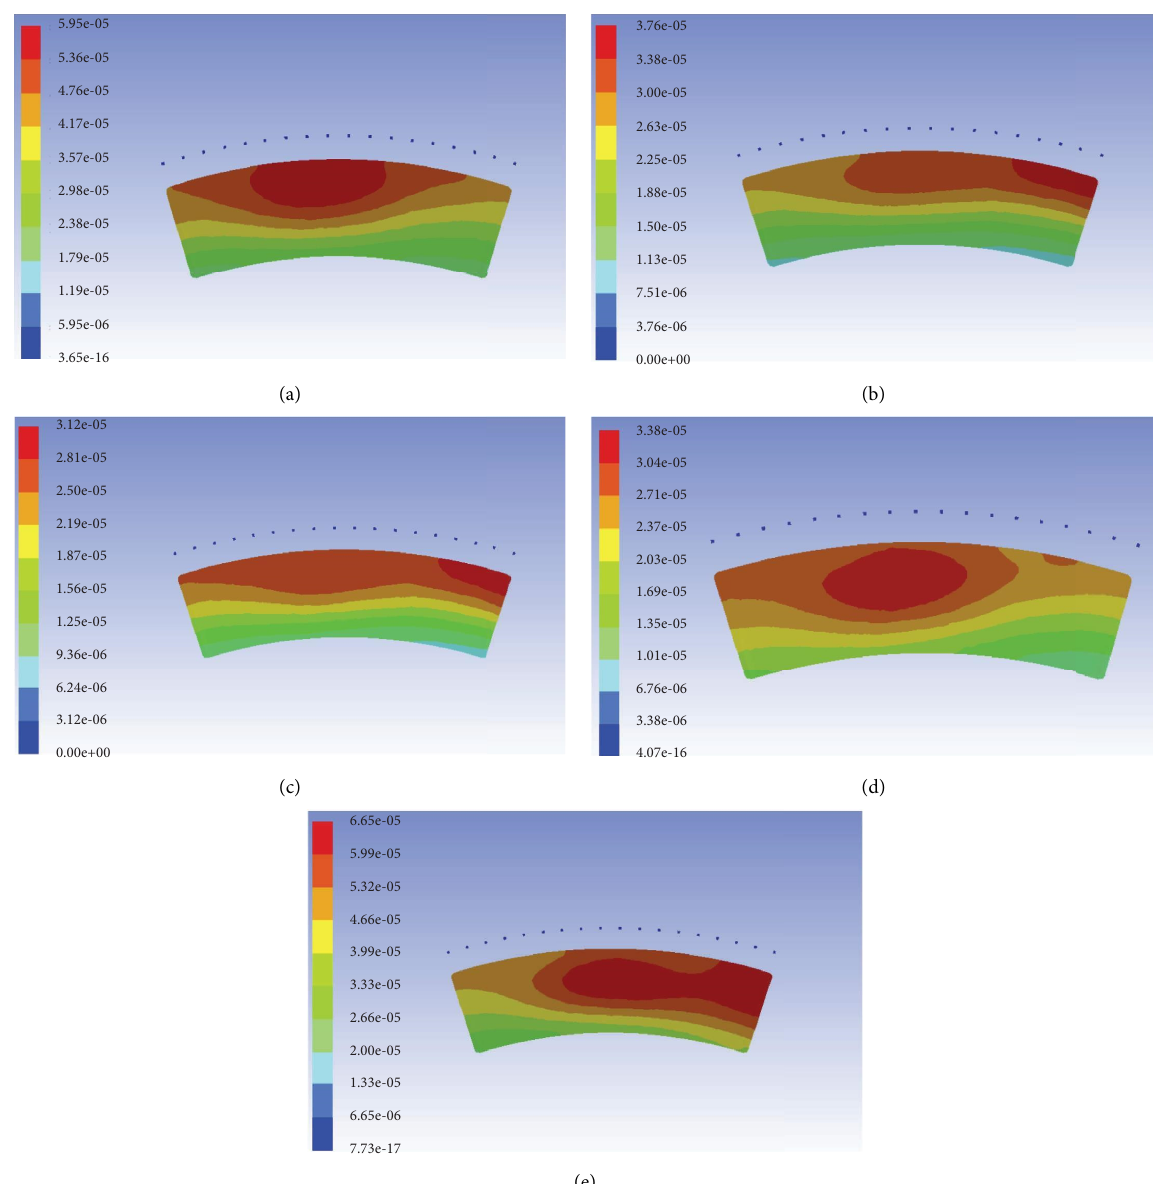
Figure 11: Contours of mass fraction of NO at the outlet section of a combustion chamber for diferent volume content of hydrogen in the mixture: 0% (a), 25% (b), 50% (c), 75% (d), and 100%